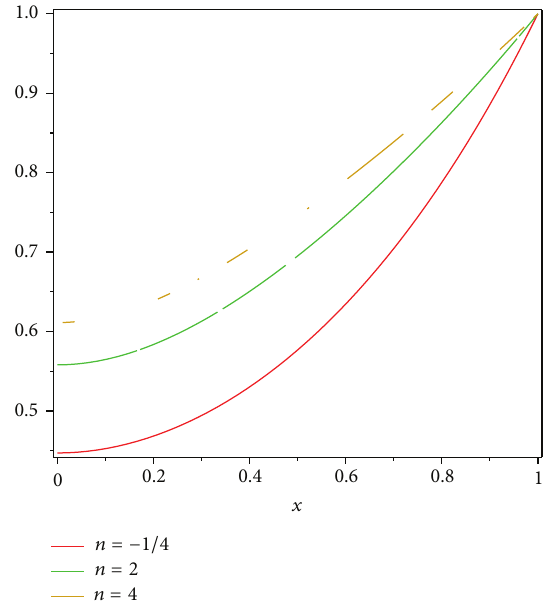
Figure 3: Temperature 𝑓(𝑥) = √𝑥 + 1 given in (18) in a fin with varying values of 𝑛 .